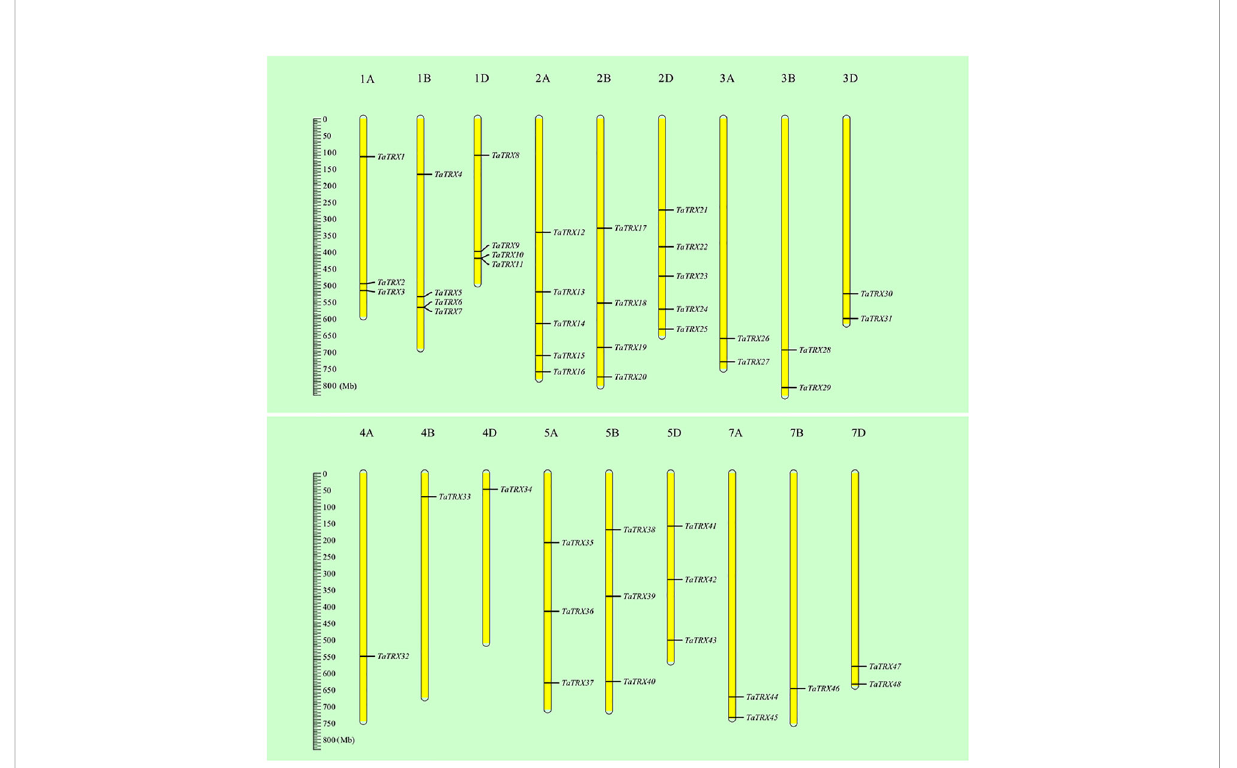
FIGURE 1 Relative positions of typical TaTRX family members in wheat on chromosomes. All wheat chromosomes were drawn to scale based on their actual physical